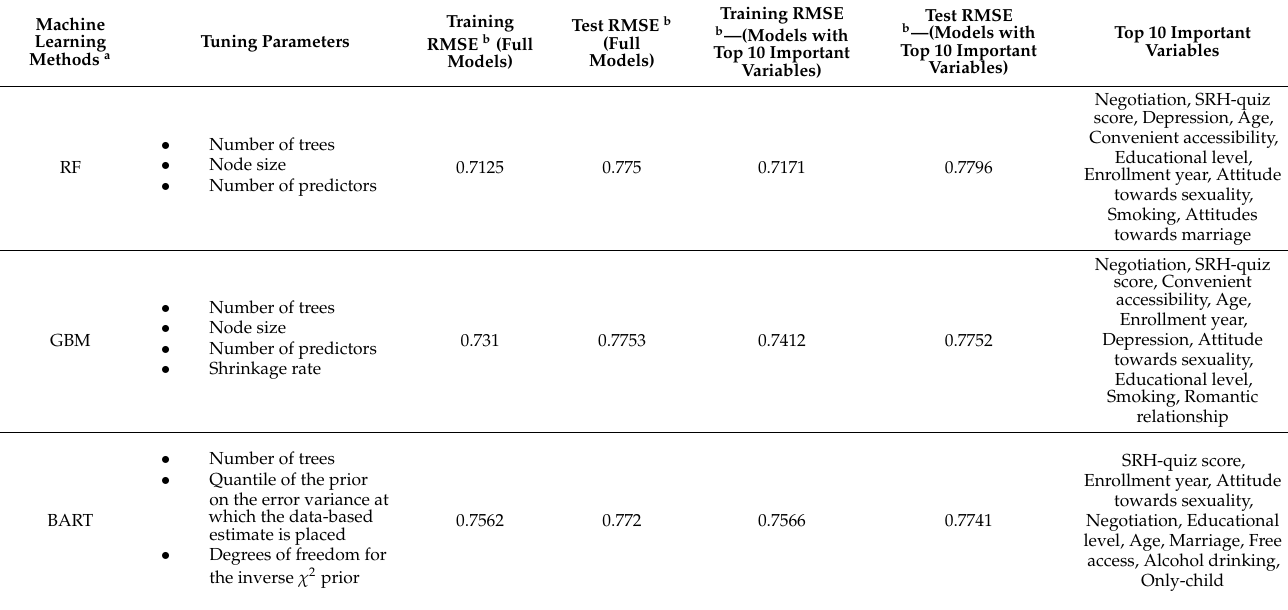
Table 1. Model performance and identified key